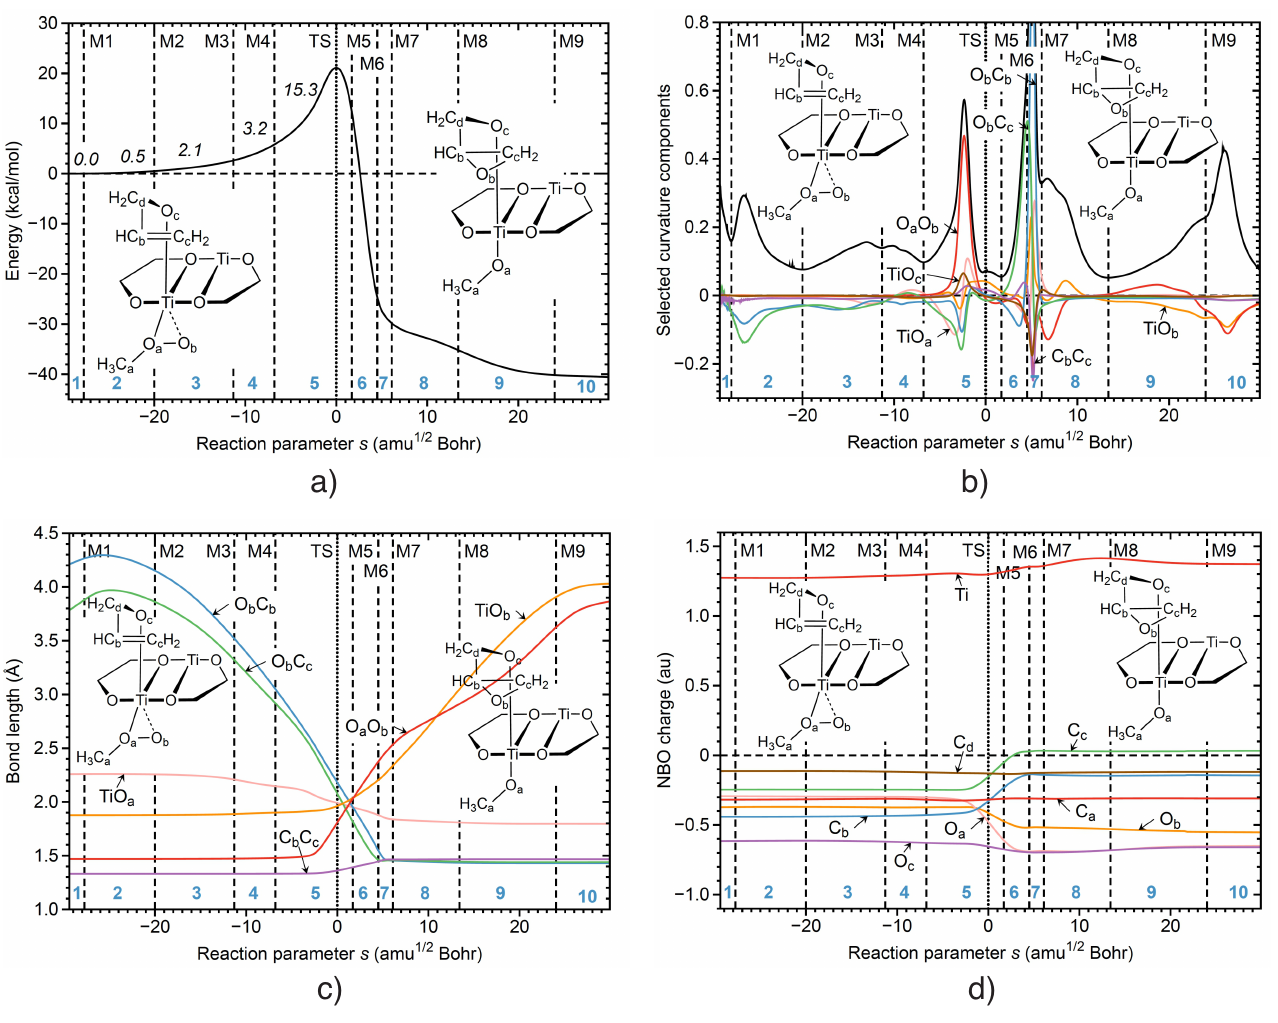
Figure 7. Properties of reaction R4 along the reaction path. ( a ) The energy profile. ( b ) Decomposition of the reaction curvature into selected chemical bonds. ( c ) The change of the selected bond lengths. ( d ) The change of the selected NBO atomic charges. The curvature minima are shown as broken vertical lines and are labeled as M1, M2 and so on. The position of TS is indicated as a dotted line. The reaction phases are indicated by blue numbers. B3LYP/6-31G(d,p)/SDD(Ti) level of